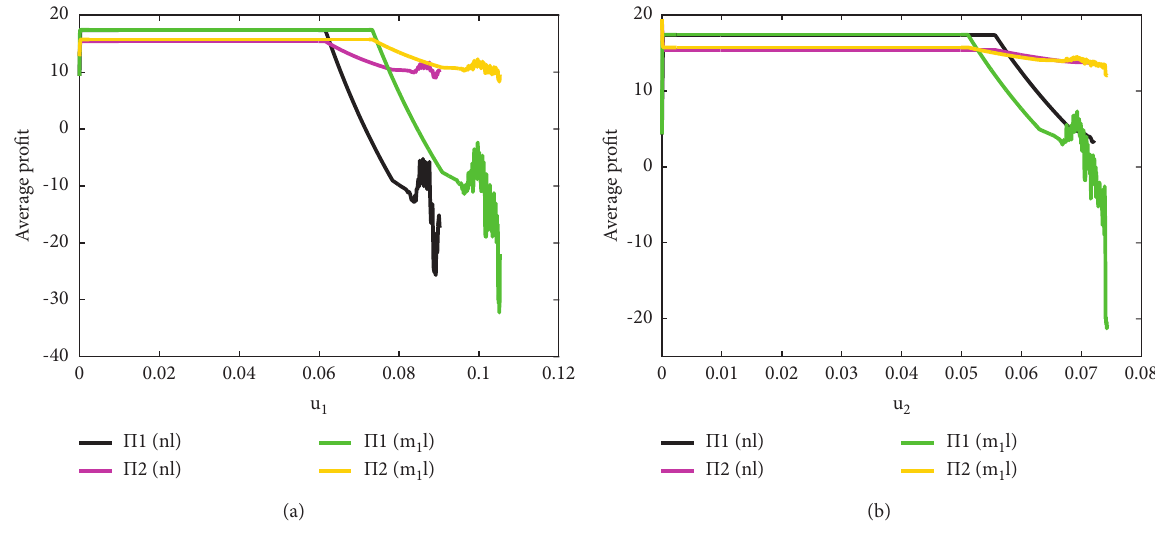
Figure 7: Change of average profit with respect to u